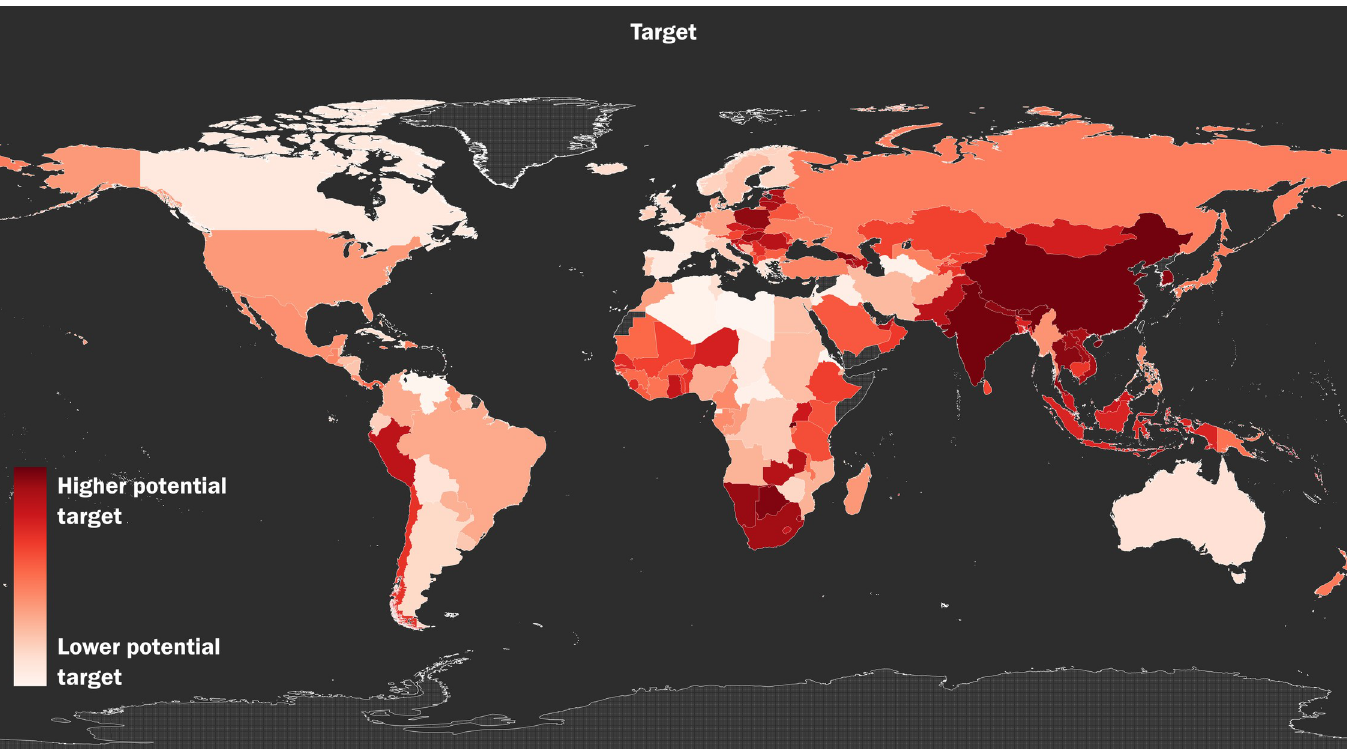
Fig 5. The global distribution of Target . The global distribution of Target , a measure of a country’s climate impacts risk, toxic pollution risk, and their potential readiness to mitigate these risks.